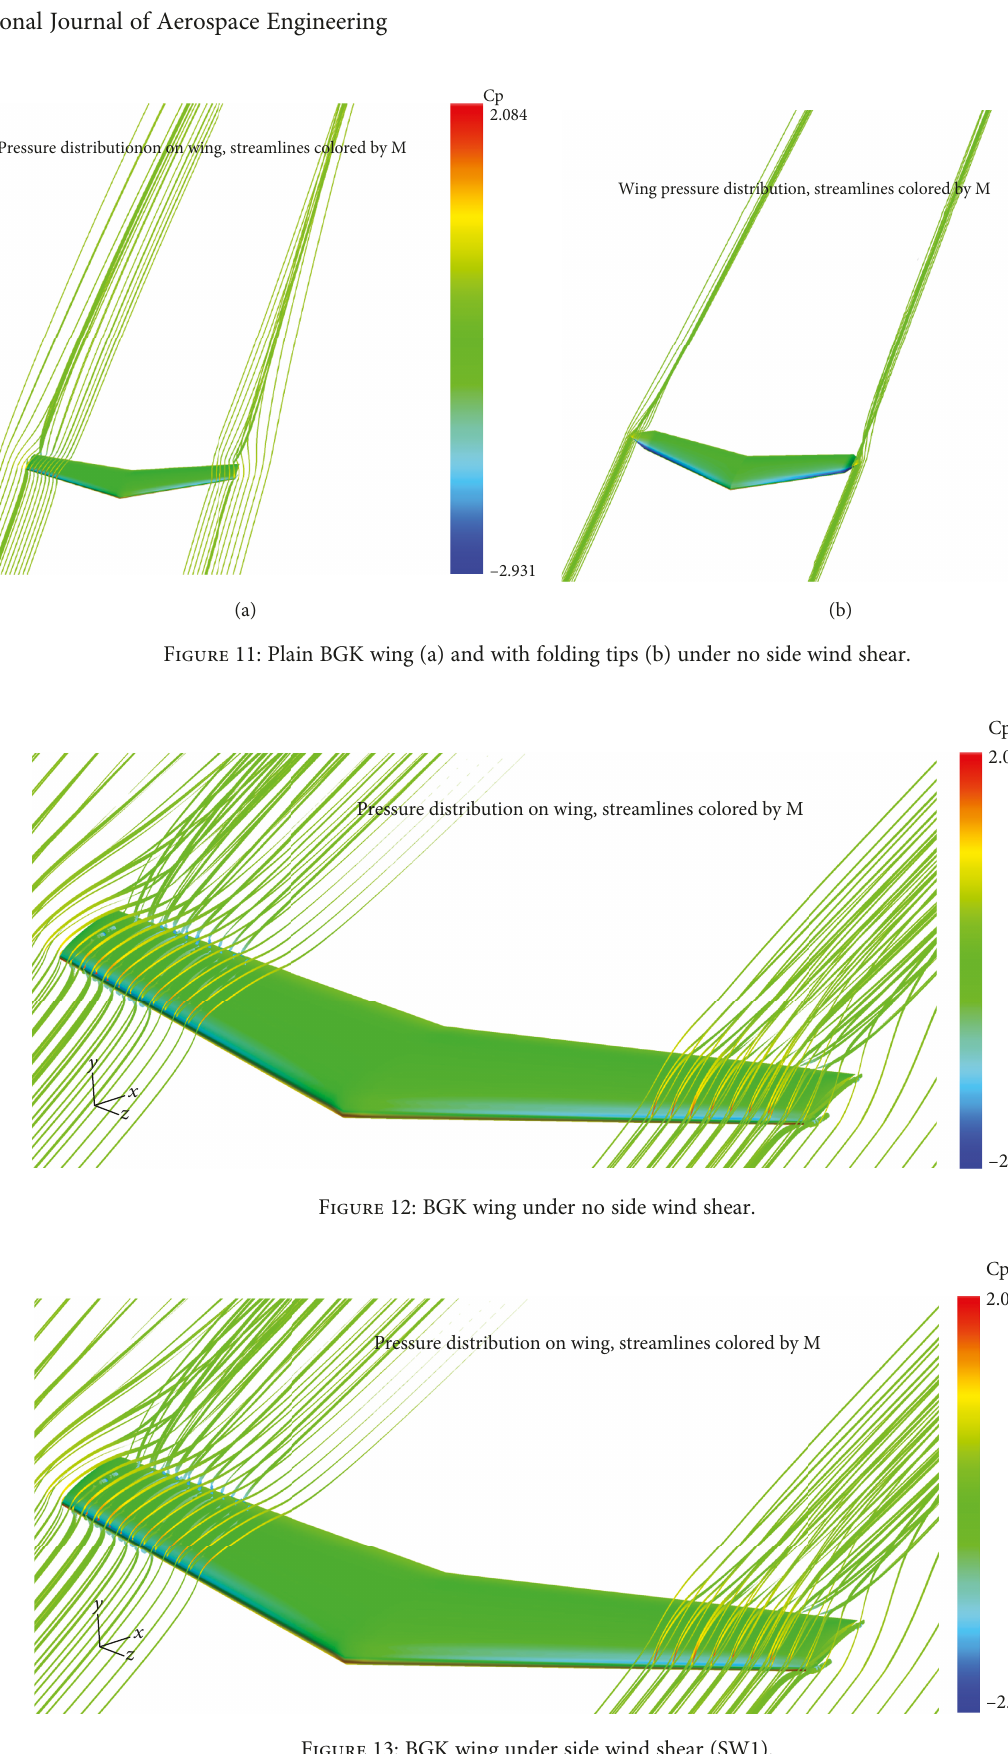
Figure 13: BGK wing under side wind shear